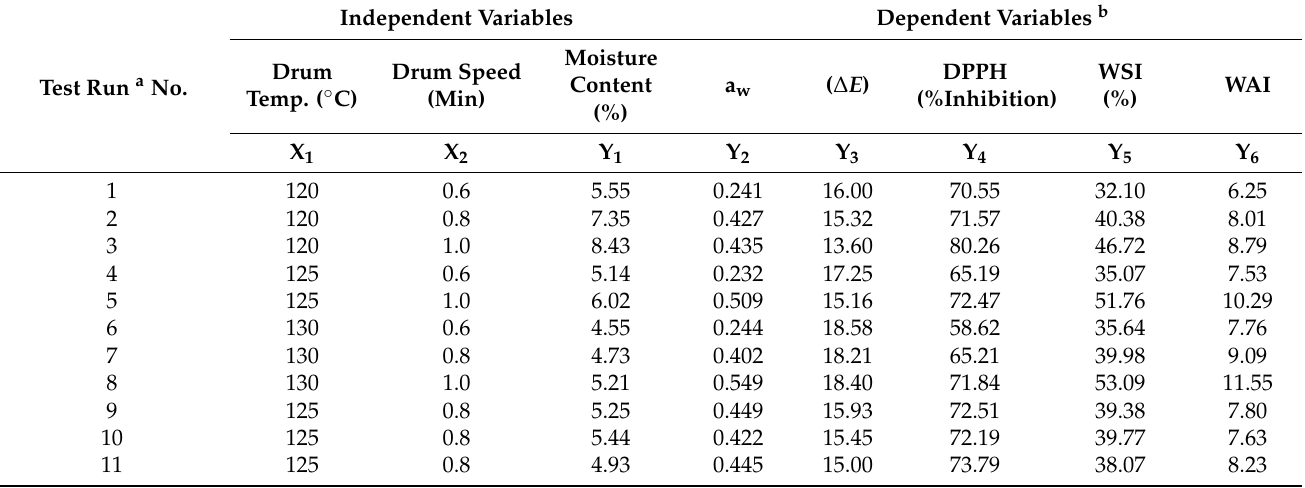
Table 2. Structure of the factorial design and the dependent variable responses under drum drying process conditions (independent variables).